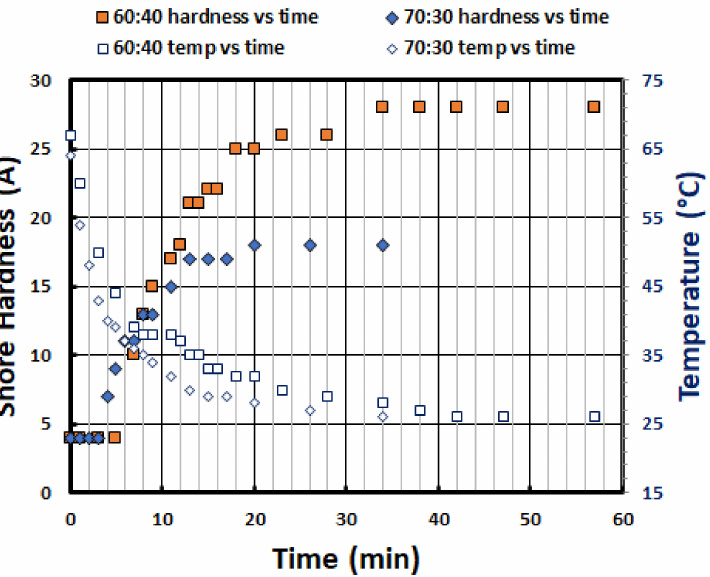
Figure 5. Evolution of shore hardness during cooling in the air for two solid SMH samples with 30% PCL and 40% PCL,